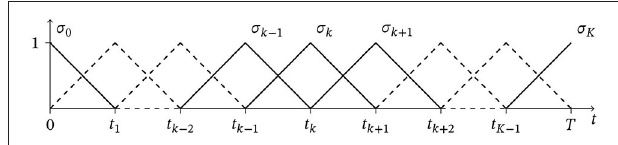
FIGURE 1 | Piecewise linear temporal discretization (hat